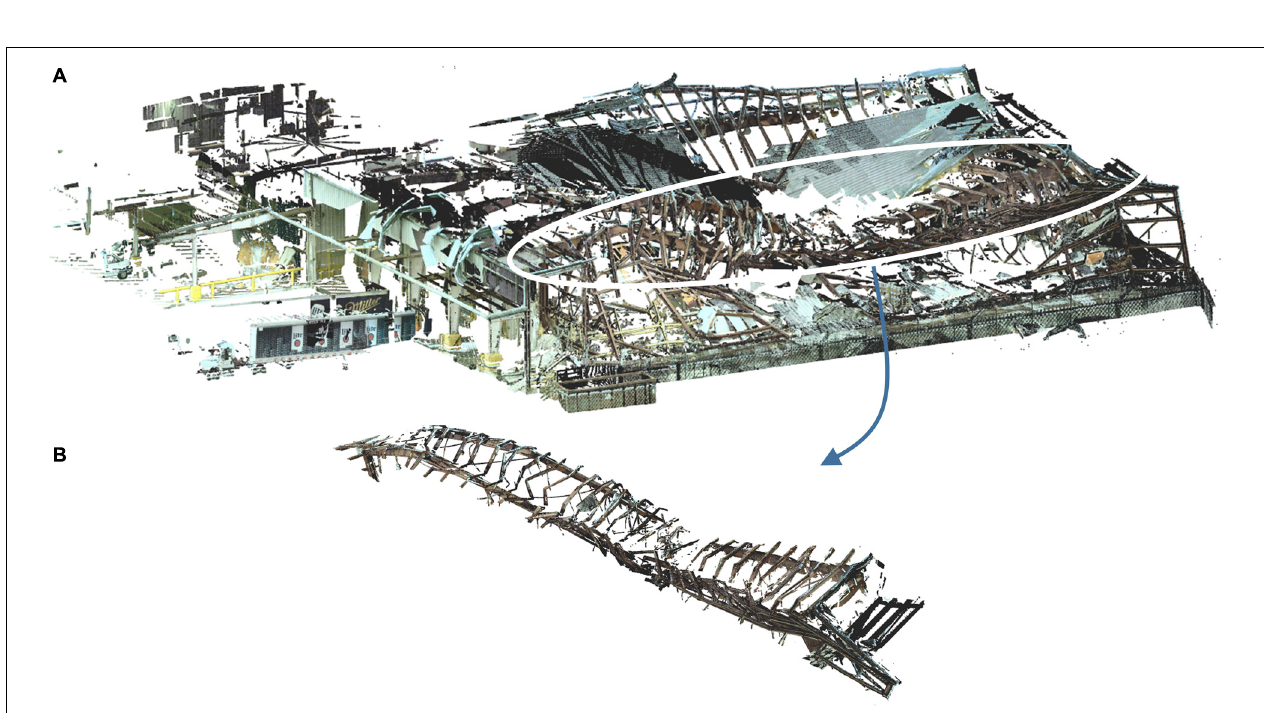
FIGURE 8 | (A) 3D point cloud from lidar scans of the exterior of a beverage distribution building. Scans were only obtained from one side of the building, showing the shorter face of the building and the collapsed roof framing members. (B) Two lines of main girders [circled in (A) ] and their connected roof purlins extracted from the full point